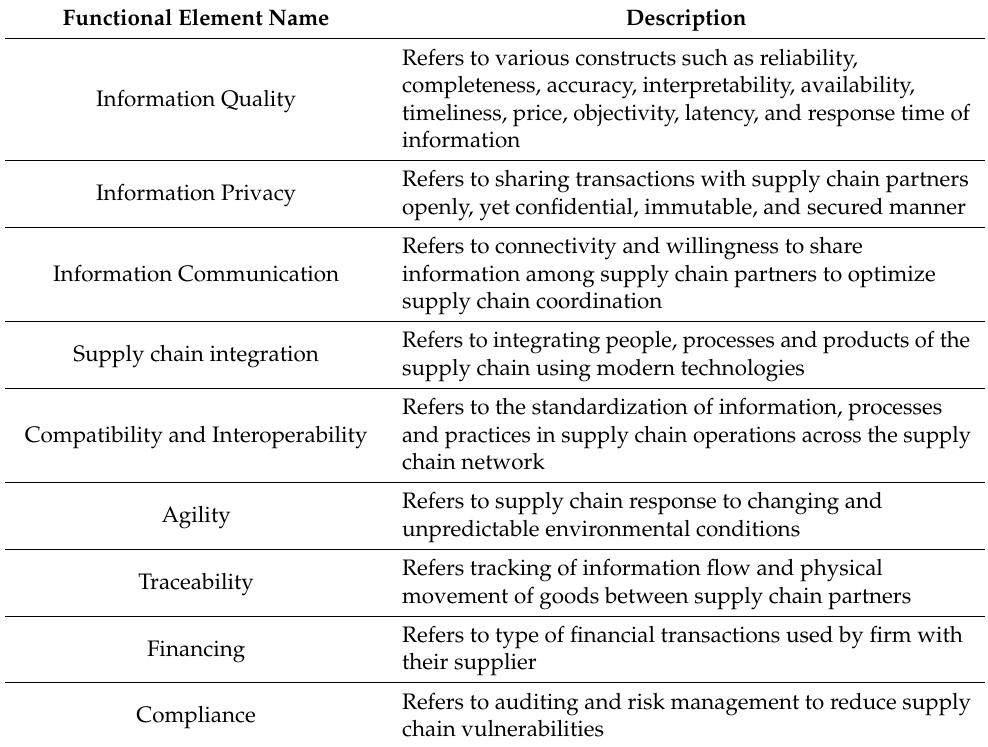
Table 1. Summary of functional elements in supply chains.